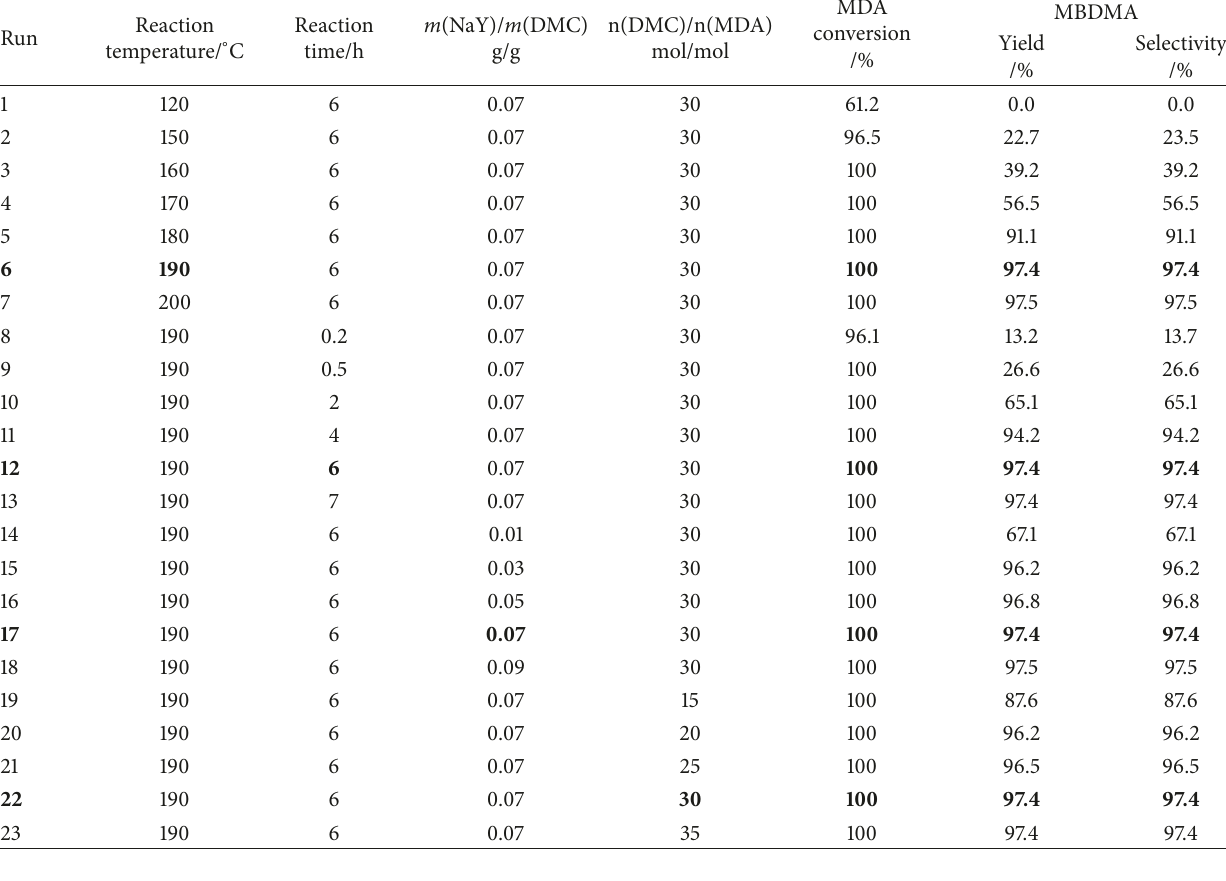
Table 3: The effect of the reaction conditions on the formation of MBDMA over NaY zeolites.